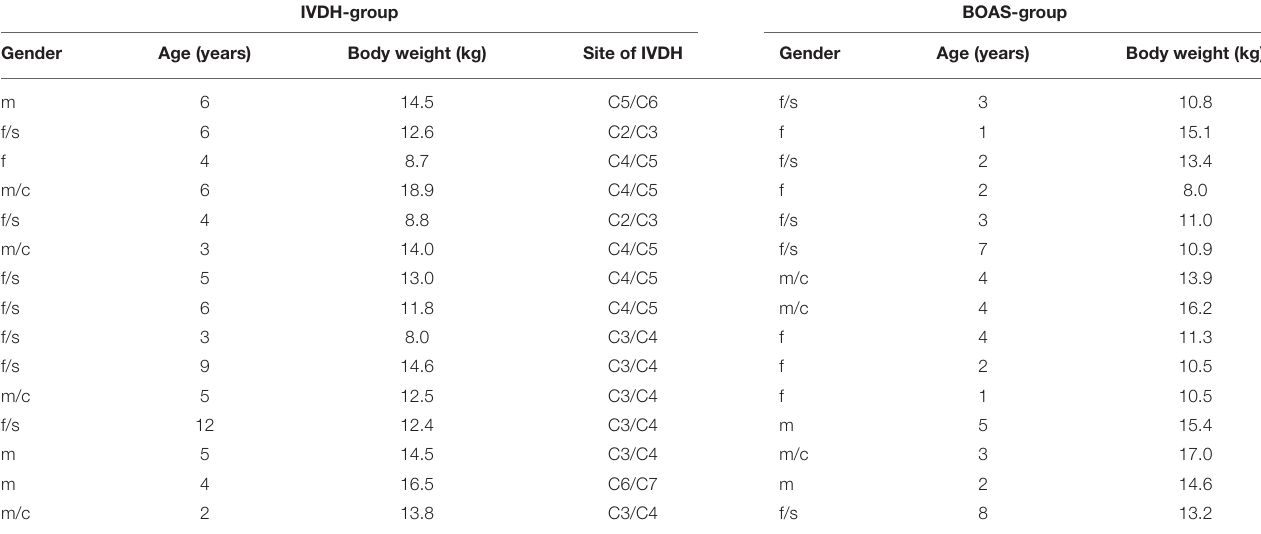
TABLE 1 | Demographics of the patients in both IVDH-group and BOAS- group, including gender (f, female; m, male; s, spayed; c, castrated), age (years), body weight (kg), and site of IVDH. IVDH-group BOAS-group